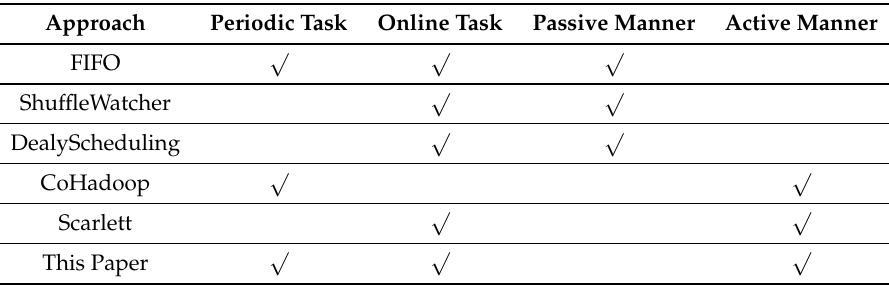
Table 1. The feature comparison for representative